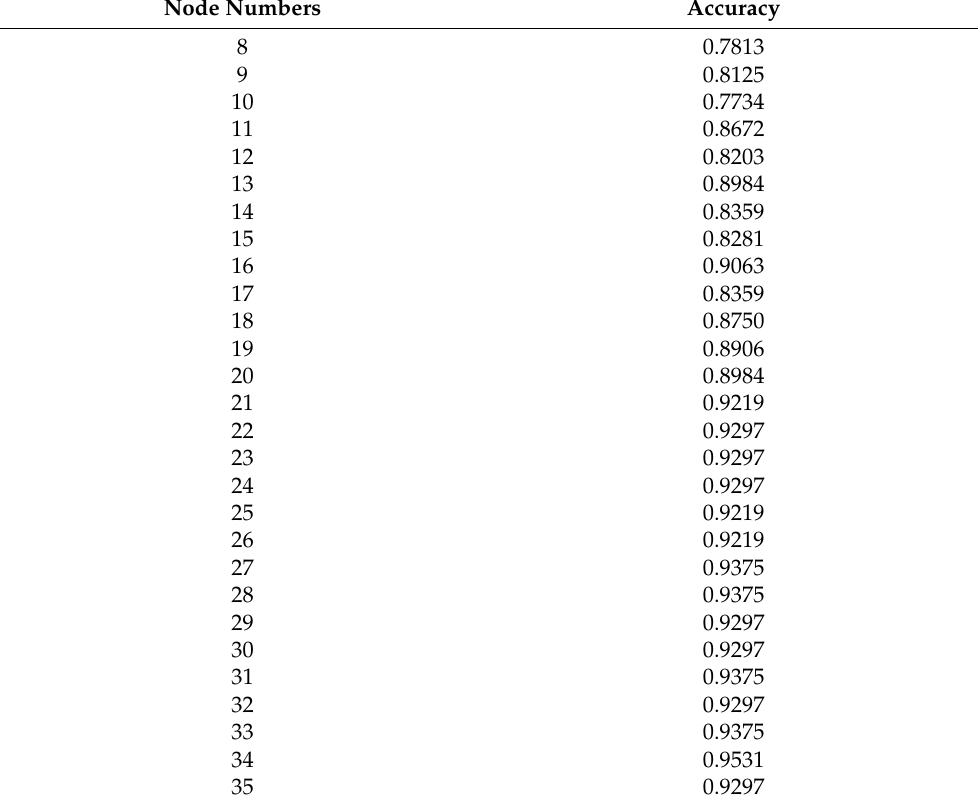
Table 4. Relationship between node number and accuracy of SAPSO-ELM training set.